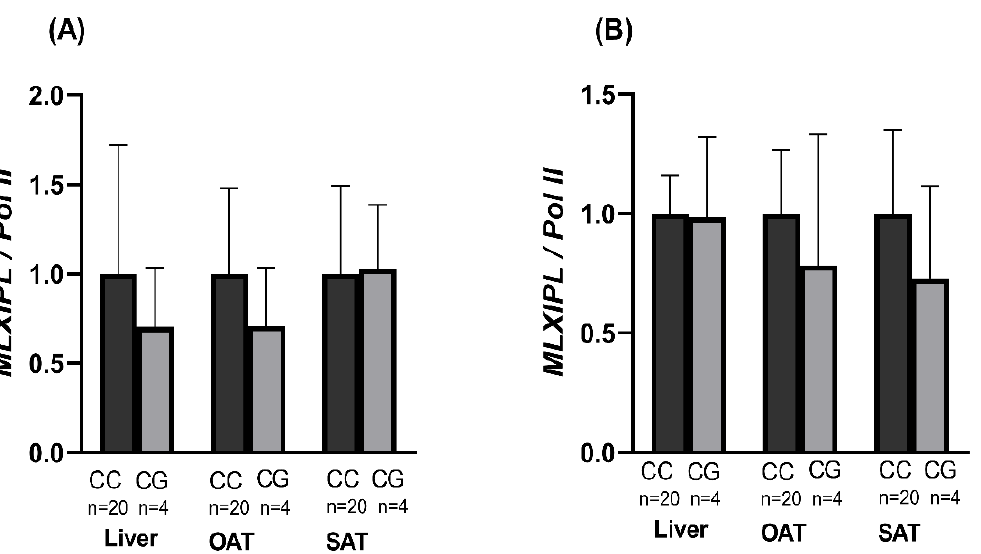
Figure 5. Gene expression of ChREBP α and β isoforms according to the rs3812316 SNV of MLXIPL gene. Units of relative expression ( A ) of ChREBP- α and ( B ) ChREBP- β isoforms according to the rs3812316. Bars represent mean ± SD (standard deviation). Comparisons between genotypes were performed with the Mann–Whitney U test. A p -value < 0.05 was considered statistically significant. Gene expression was performed by qPCR and using the 2 − ∆∆ CT method. OAT: Omental adipose tissue, SAT: Subcutaneous adipose tissue, qPCR: quantitative polymerase chain reaction.